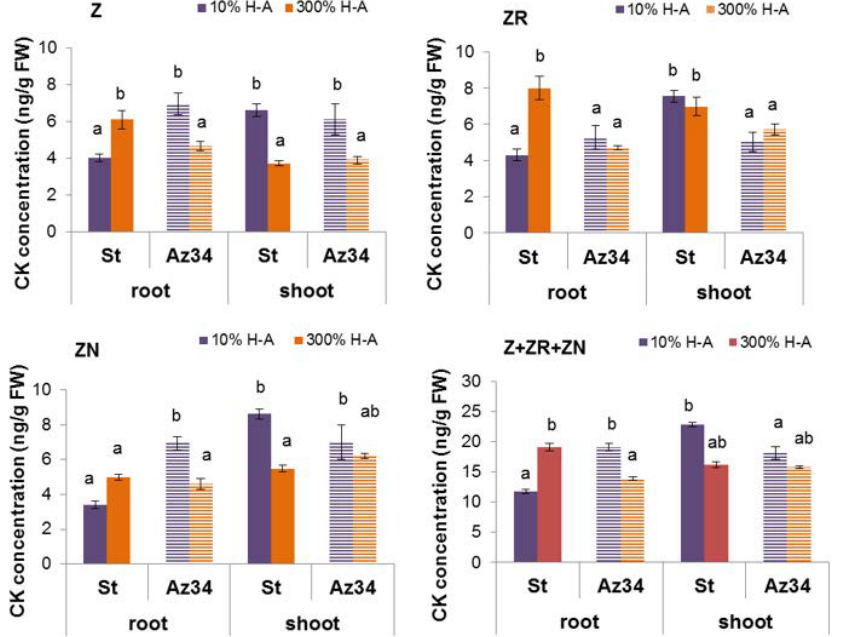
Figure 2. Concentration of zeatin (Z), zeatin riboside (ZR), zeatin nucleotide (ZN) and their sum (Z+ZR+ZN) in roots and shoots of 6-da-old barley wild type (Steptoe) and its ABA-deficient mutant (Az34) growing at 10% of supra-optimal (300%) Hoagland-Arnon solution (H-A). Means ± SE are presented. Statistically different means (n = 9) are indicated by different letters ( p < 0.05, ANOVA, Duncan’s test).